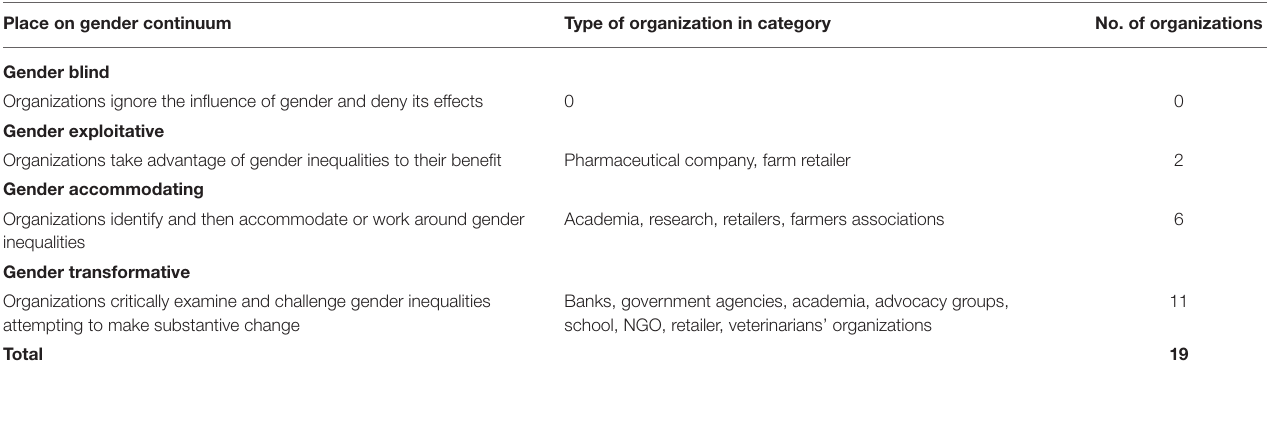
TABLE 3 | Classification of organizations along the gender equality continuum using the GECT. Place on gender continuum Gender